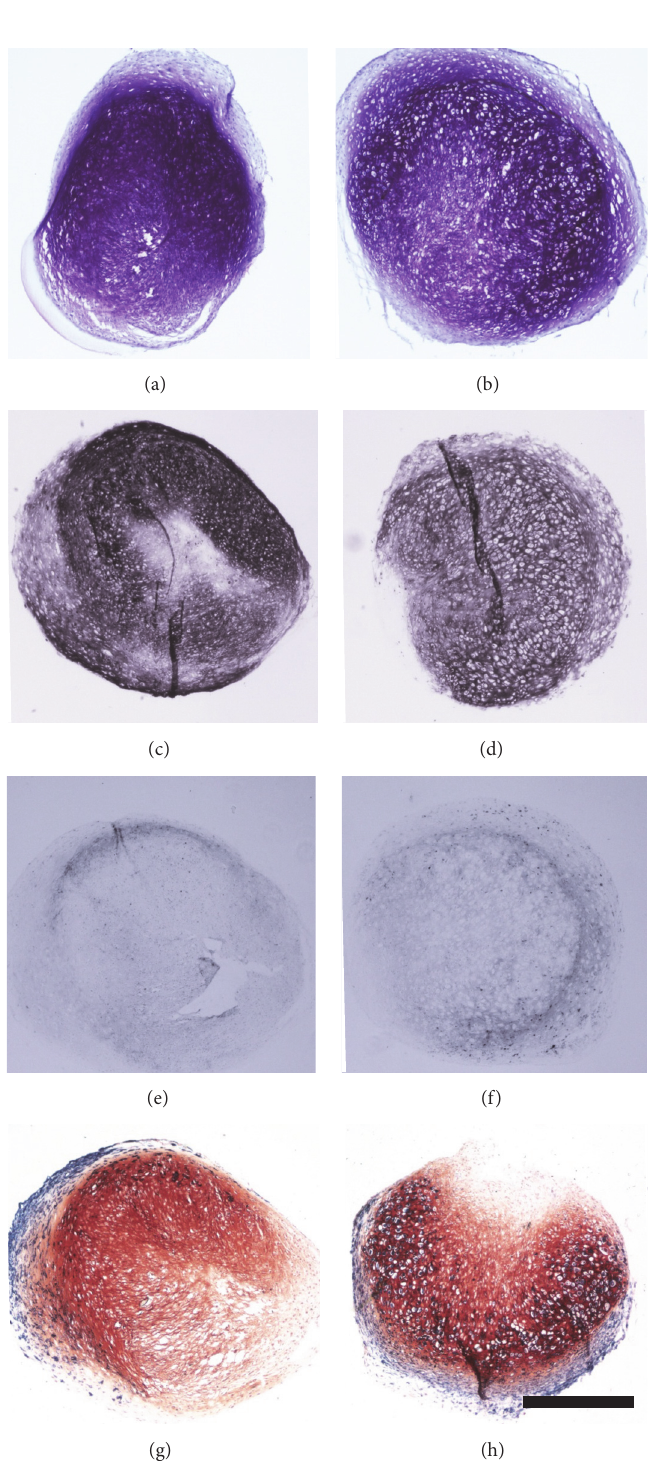
Figure 2: Differences in glycosaminoglycan content shown by DMMB staining of cell pellets after chondrogenic (chon) (a) and hypertrophic (hyp) conditions (b), as well as different collagen 2 production as revealed by immunohistochemistry against collagen 2 of cell pellets after chondrogenic (c) and hypertrophic conditions (d). Enhancement of hypertrophy shown by immunohistochemistry against collagen 10 between chondrogenic (e) and hypertrophic (f) conditioned cell pellets as well as by ALP staining of chondrogenic (g) and hypertrophic (h) conditioned cell pellets. Scale bar = 500 𝜇